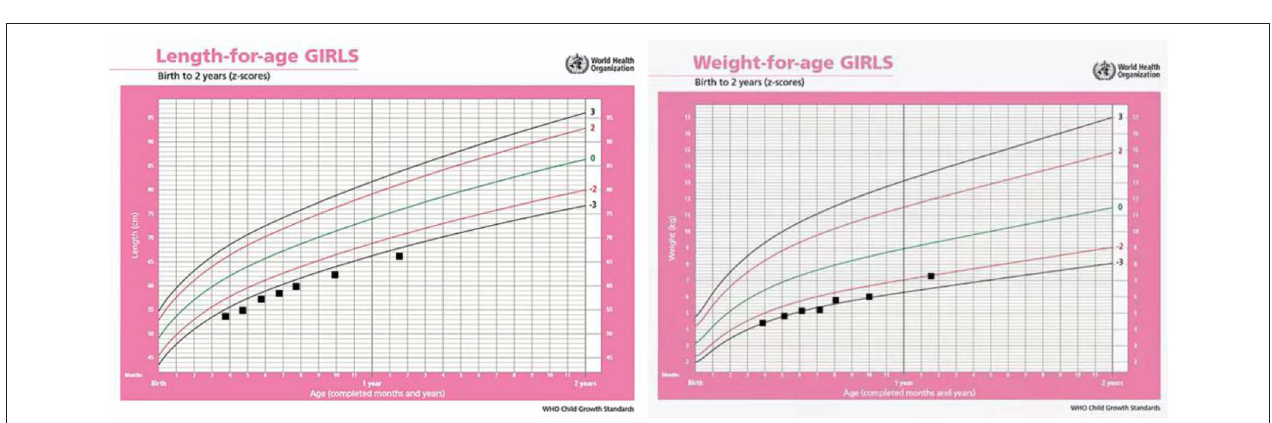
FIGURE 3 | Growth chart of the patient from 4 to 19